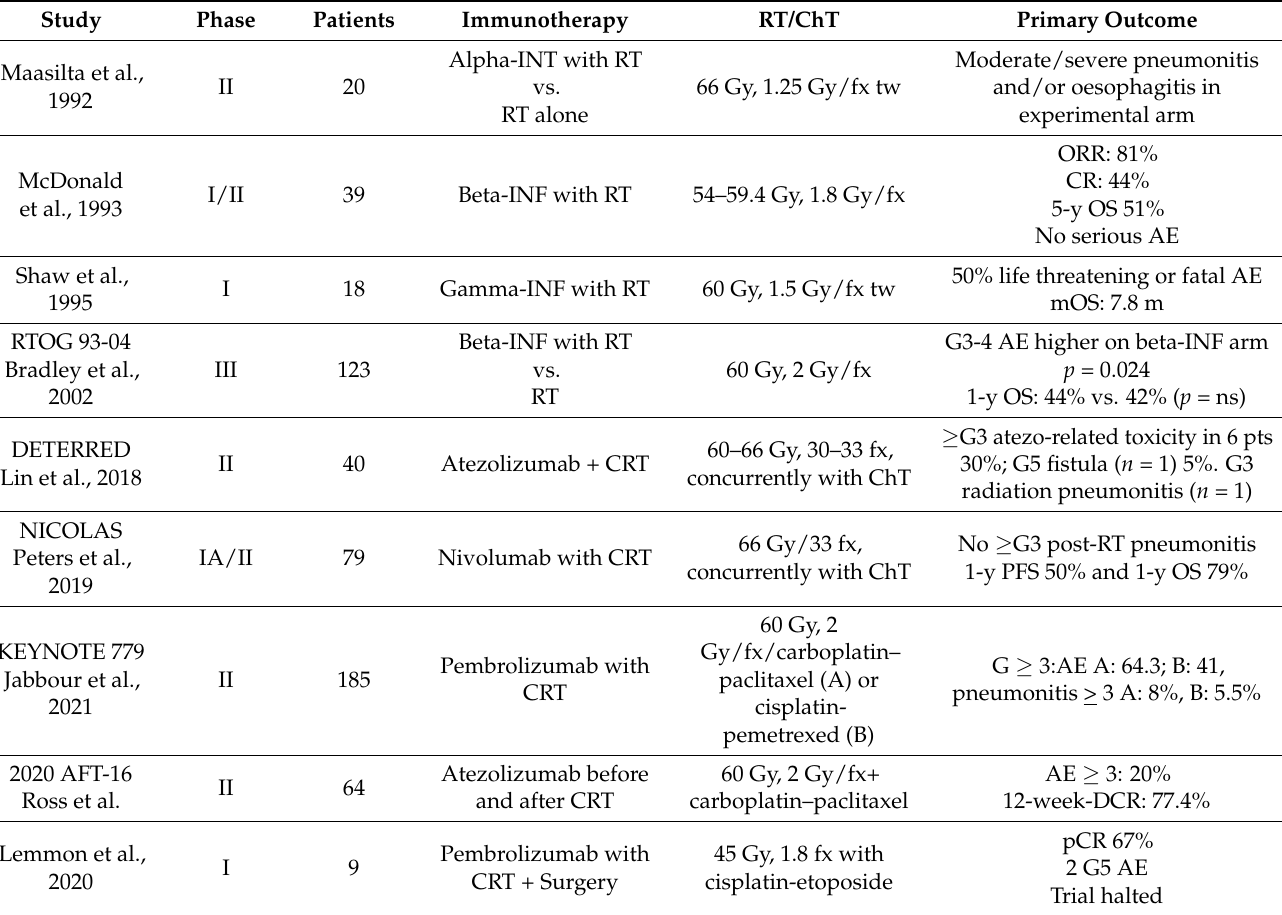
Table 6. Studies evaluating immunotherapy with concurrent CRT in stage III